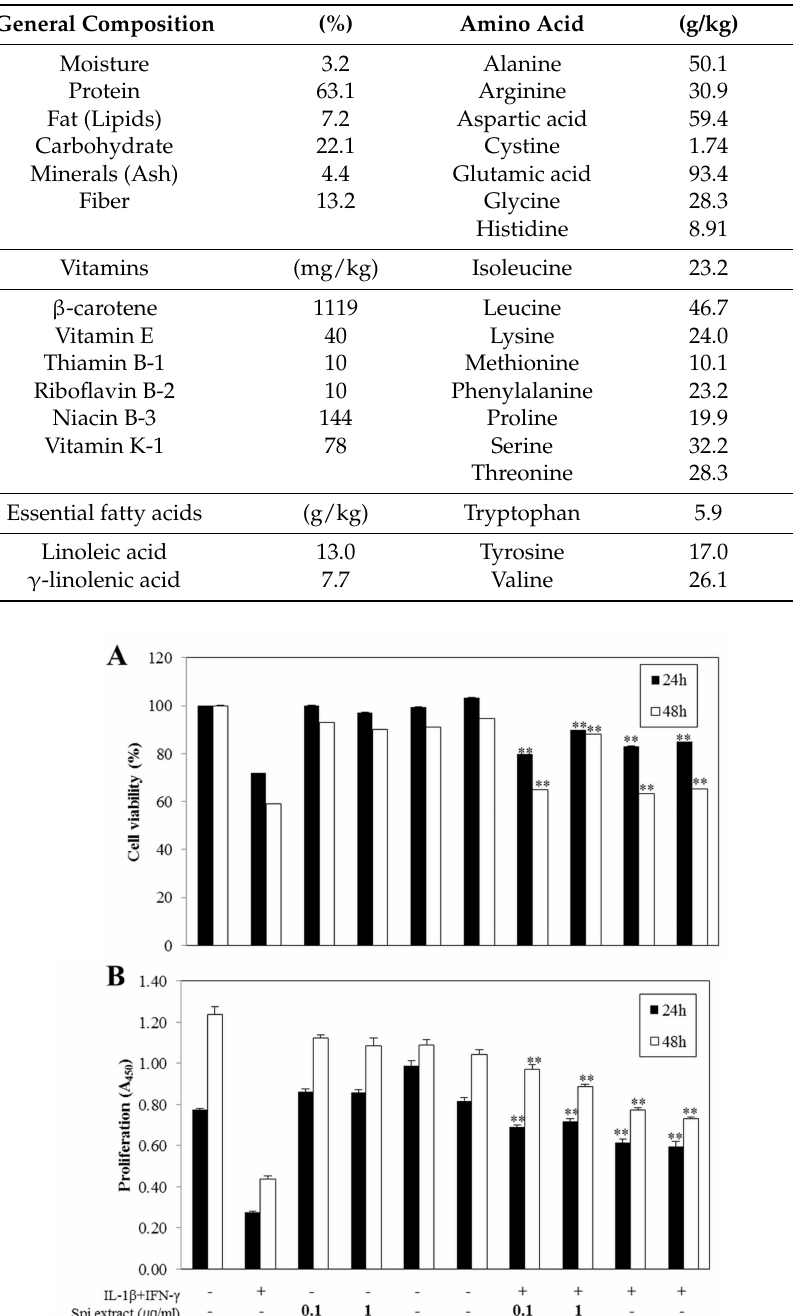
Table 2. Compositions of Spirulina maxima .